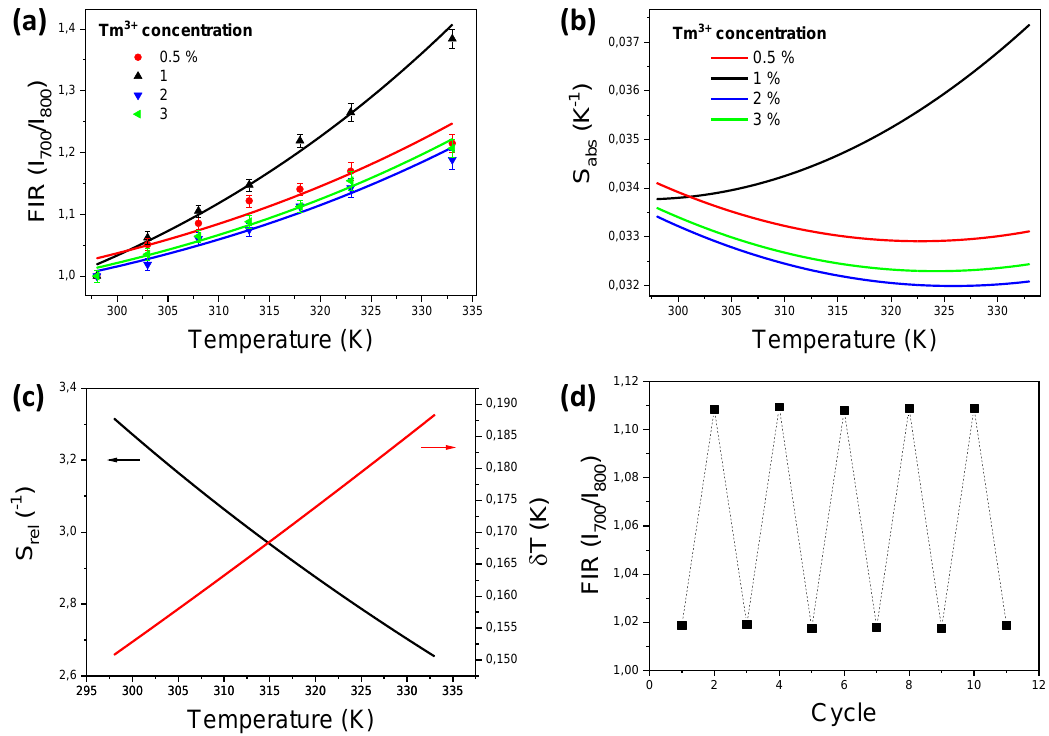
Figure 3. ( a ) Normalized fluorescence intensity ratio ( FIR) as a function of temperature for the Tm,Yb:GdVO 4 @SiO 2 core-shell nanoparticles doped with di ff erent concentration of Tm 3 + . ( b ) Absolute thermal sensitivity of the (0.5–3 mol%) Tm, Yb:GdVO 4 @SiO 2 core-shell nanoparticles. ( c )